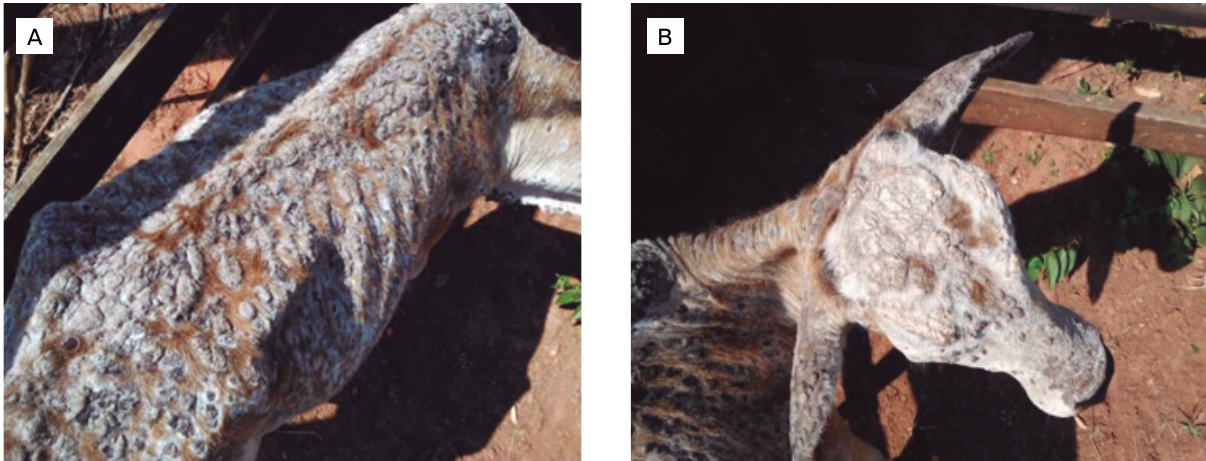
Figure 1. Generalized Dermatophilus congolensis infection in a calf. (A) Serous to purulent exudates, hair with tufted appearance, hyperkeratotic, hardened, yellowish to brown, and coalescent crusty lesions of about 2.5 in diameter distributed all over the body. (B) Detail of the head and neck lesions. Botucatu, SP, Brazil,